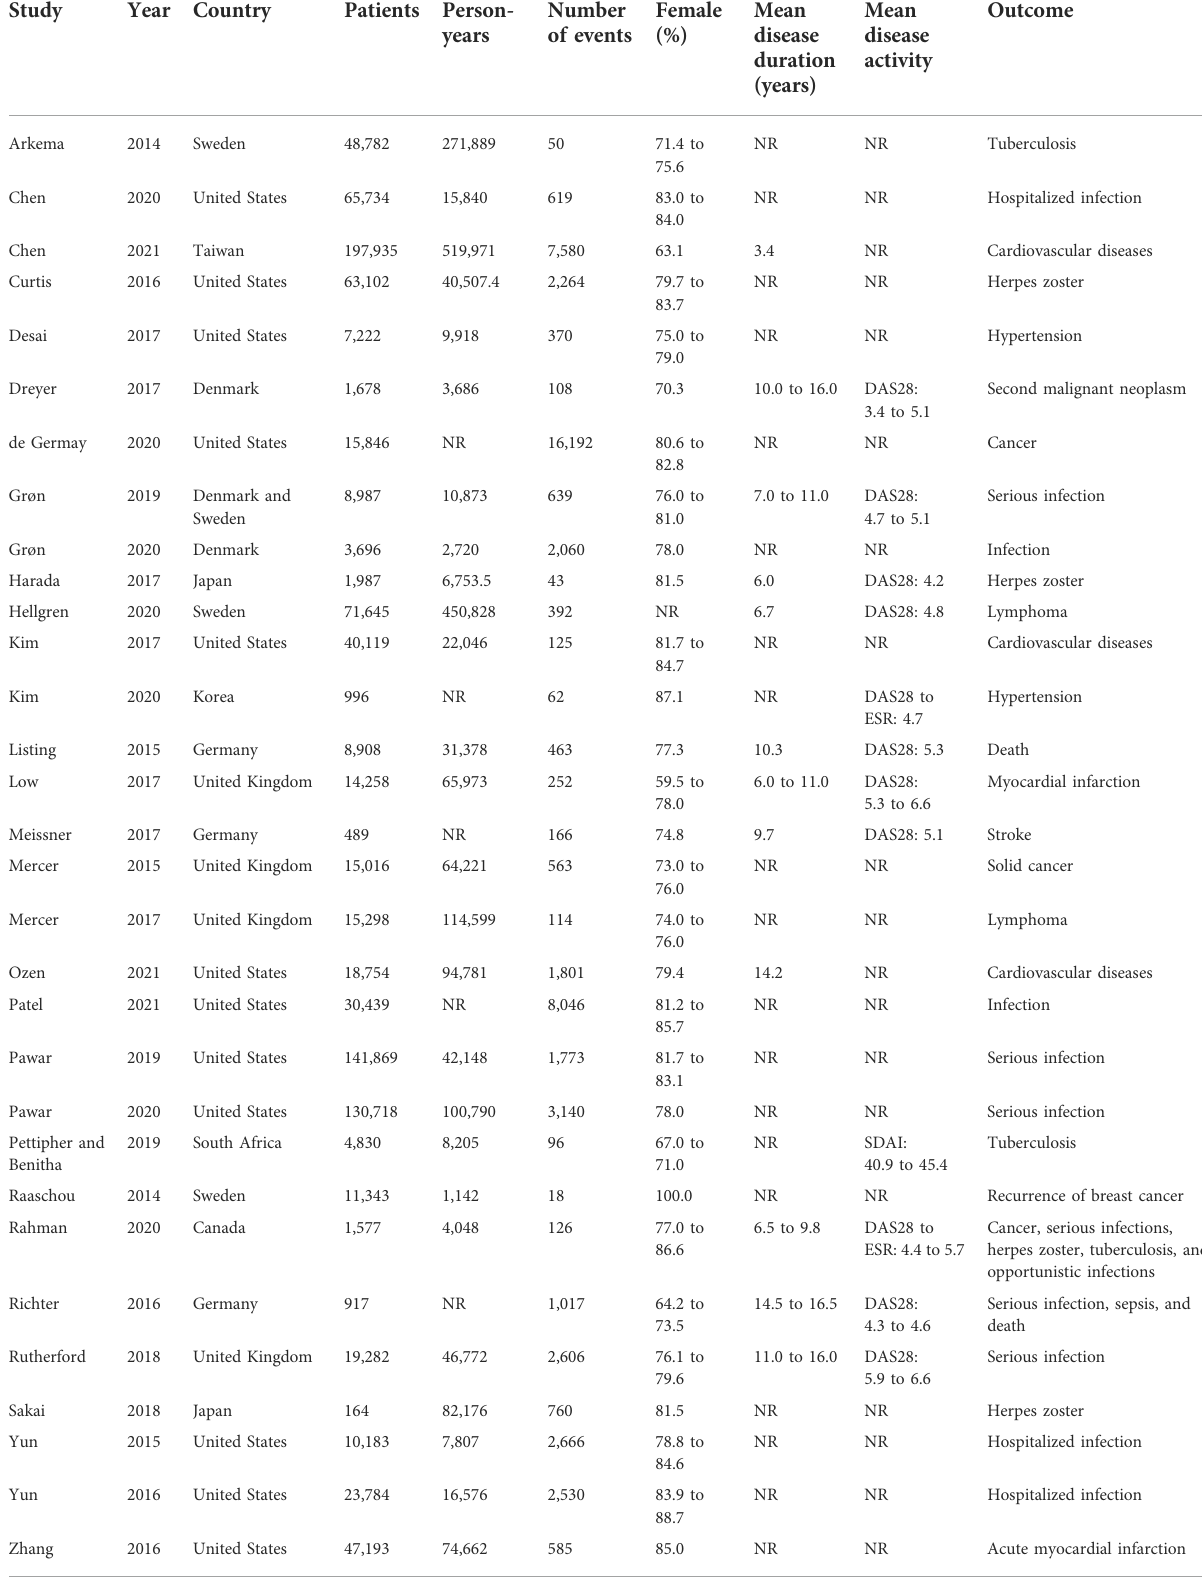
TABLE 1 Characteristics of the included studies.